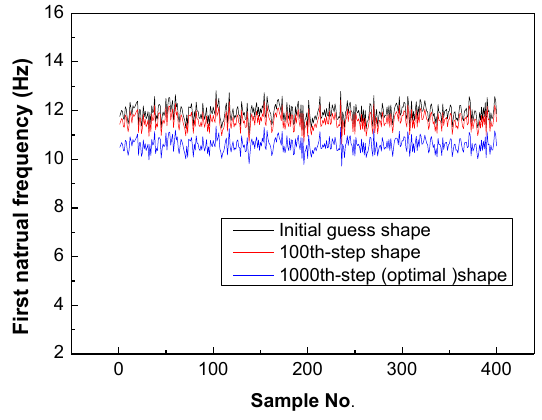
Figure 15. First natural frequency of Model 2.